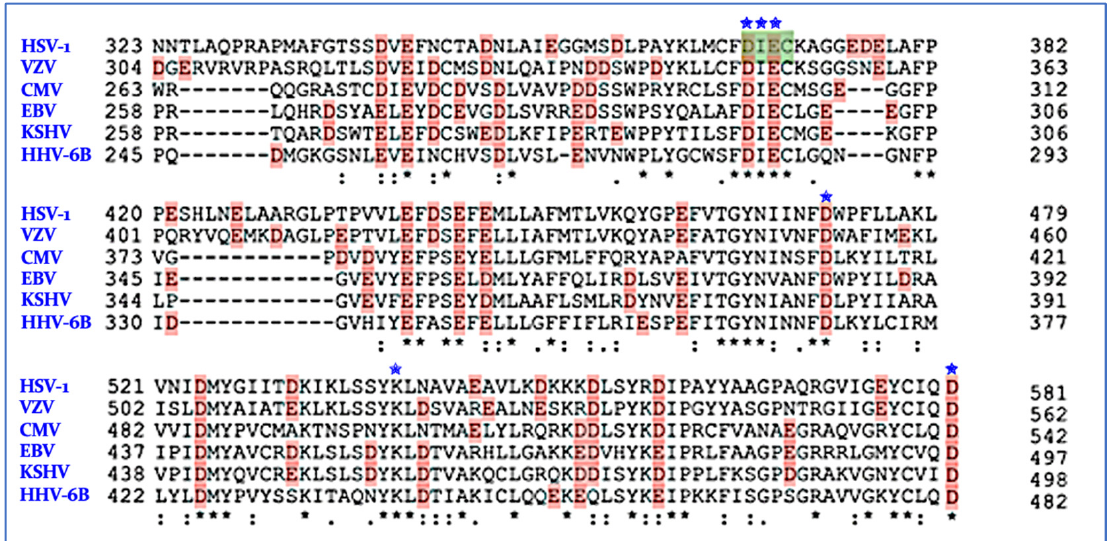
Figure 4. Active site sequence alignments of Pol/Exo regions of HSV-1, VZV, CMV, EBV, KSHV and HHV-6B. Virus name in blue text, key DIEDKD residues in red and denoted by ✬, other active site residues are in green, black stars denote identical residues, colon denotes homologous residues and period denotes a low level of similarity.